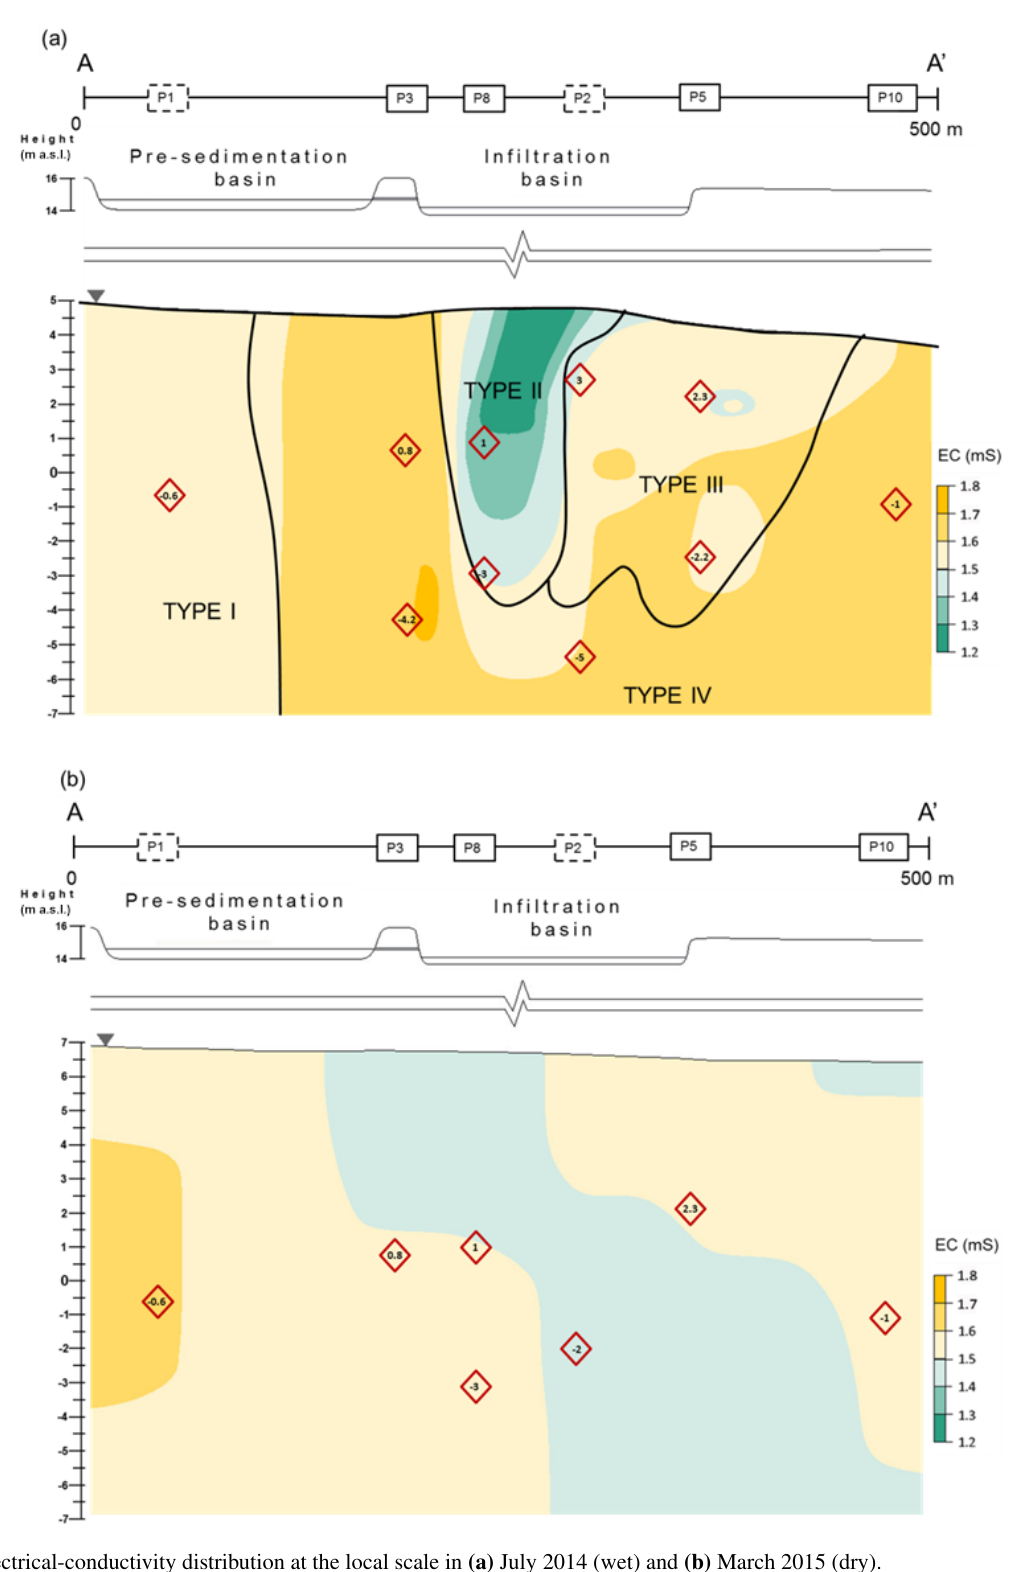
Hydrol. Earth Syst. Sci., 23, 139–154, 2019